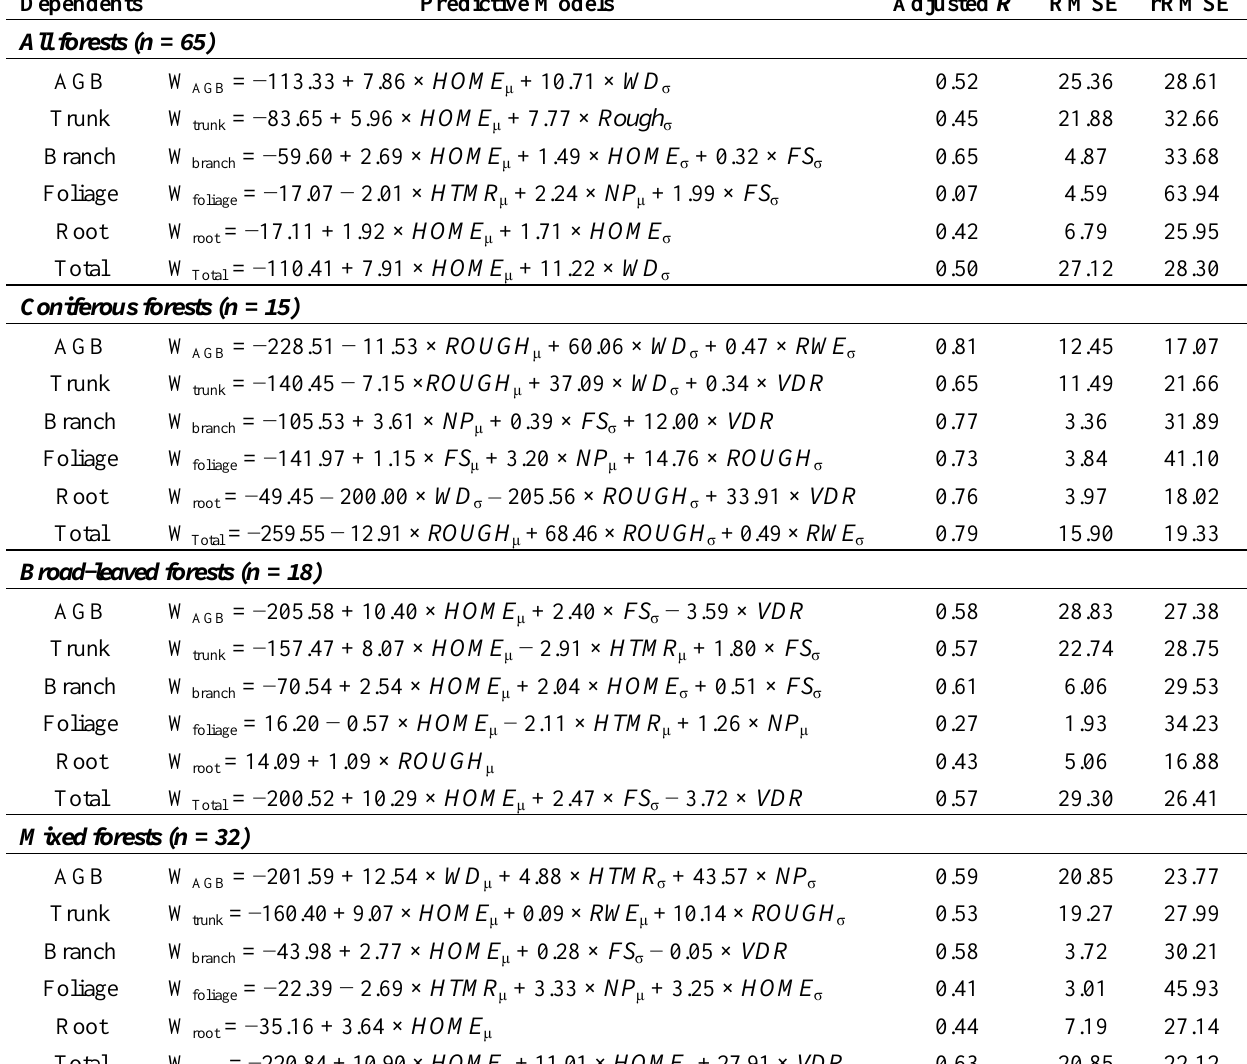
Table A2. Predictive models and accuracy assessment results (by full-waveform LiDAR metrics).